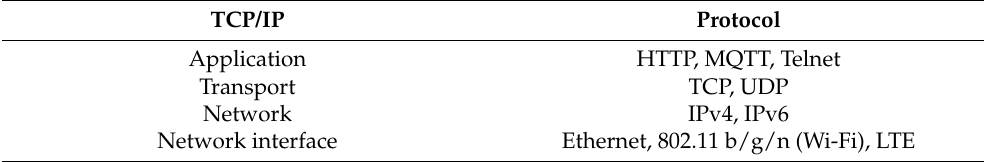
Table 7. Wireshark supported protocols.